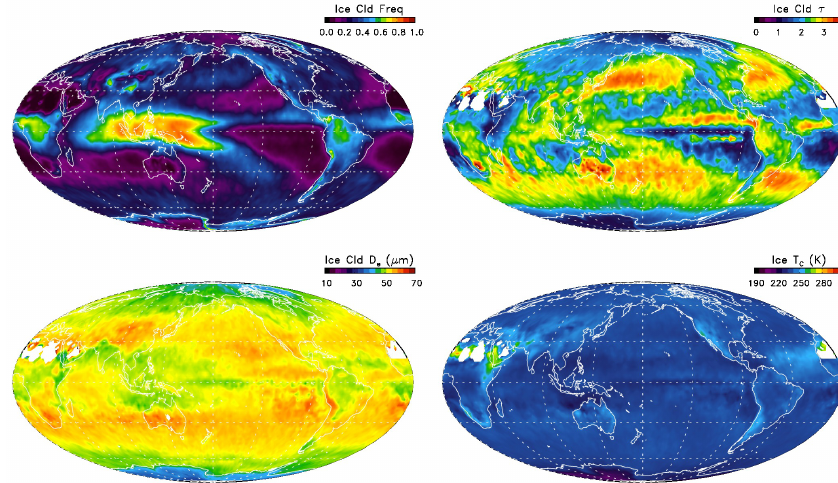
Fig. 8. Ice-phase frequency (upper left, repeat from Fig. 5), τ , D e (µm), and T C , ICE (K) for 2007.